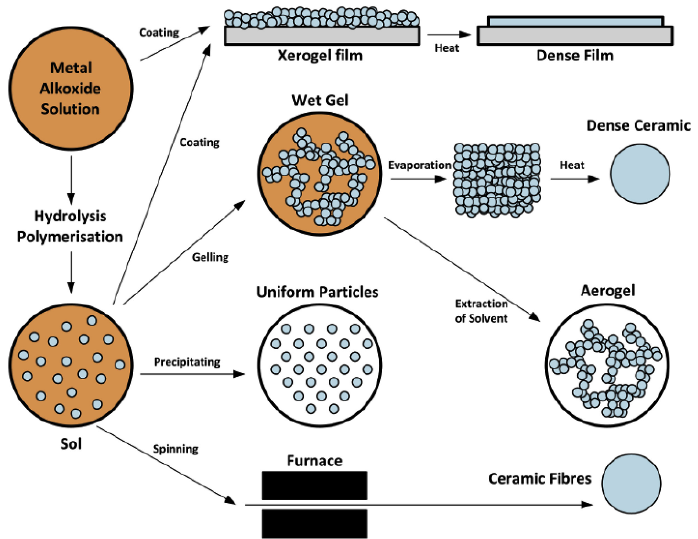
Figure 5. Schematic diagram of sol–gel technology [36].